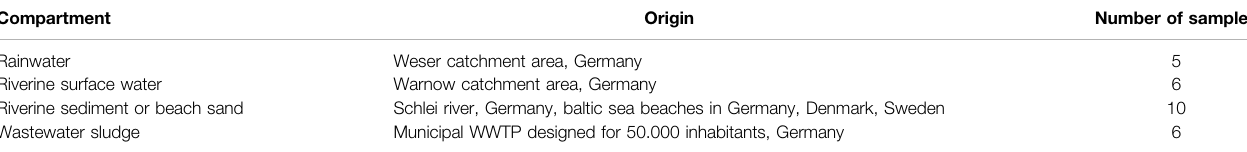
TABLE 1 | Summary of origin of analyzed samples (WWTP (cid:2) wastewater treatment plant).